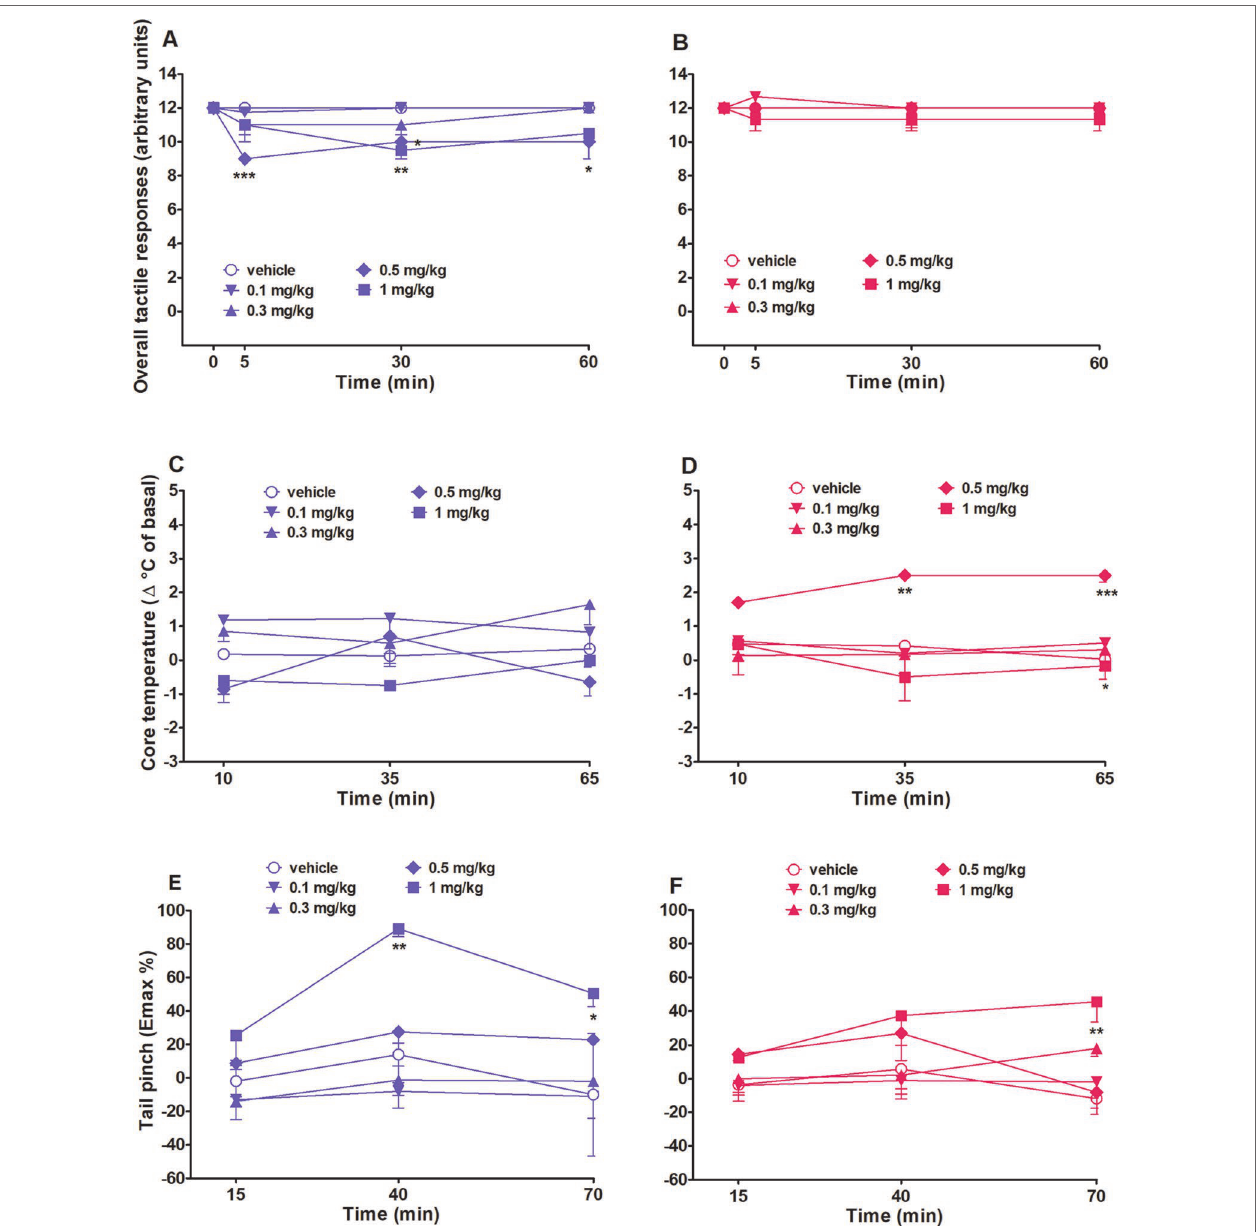
FIgURe 4 | Intraperitoneal injection (0.1–1 mg/kg) of 25I-NBOMe in male and female rats on the overall tactile responses (A and B) and on core temperature (c and D) and tail pinch test (e and F) . Data are expressed as arbitrary units (A and B) , as difference between control temperature (before injection) and temperature following drug administration (Δ°C; see Material and Methods ) (B and c) , or as percentage of maximum effect ( E max% ; (see Material and Methods ) (e and F) and represent the mean ± SEM of six animals for each treatment. Statistical analysis was performed by two-way ANOVA followed by Bonferroni’s test for multiple comparisons for the dose–response curve of each compound at different times. * p < 0.05, ** p < 0.01, *** p < 0.001 versus